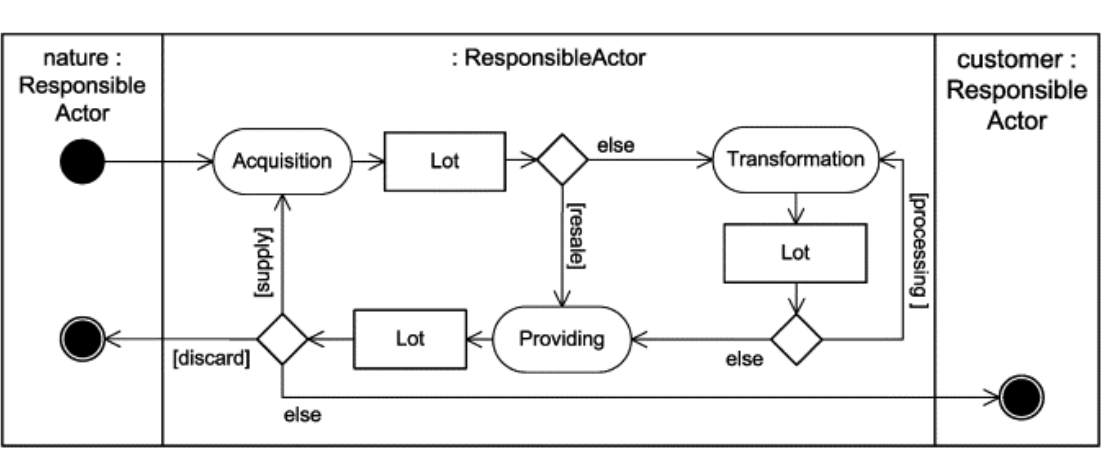
Figure 1. UML activity diagram describing the behavior of one instance of a food ingredient lot